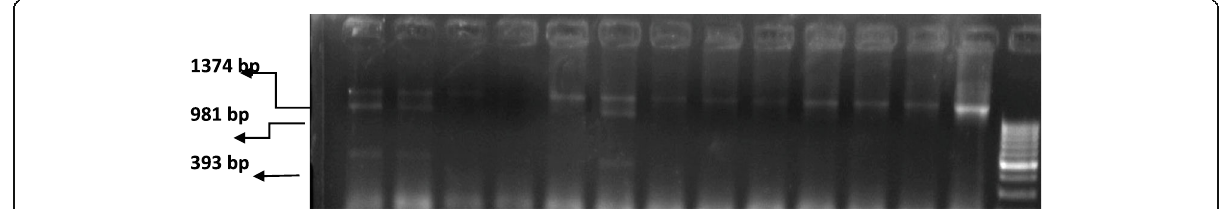
Fig. 1 Detection of Xba1 polymorphism. PCR and digestion products. Lanes 1, 2, and 6: X/x genotype (1374, 981, and 393 bp). Lanes 3, 4, 5, 7, 8, 9, 10, 11, and 12: X/X genotype (1374 bp). Lane 13: the PCR amplified product (1374 bp). M: Φ X 174 marker/Hae III